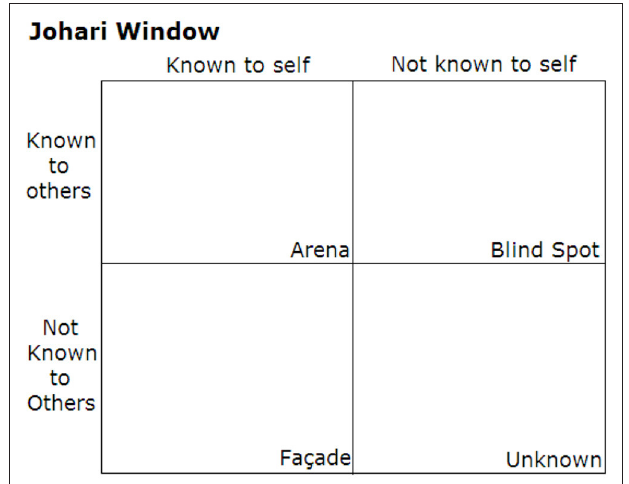
FIGURE 2 | Johari